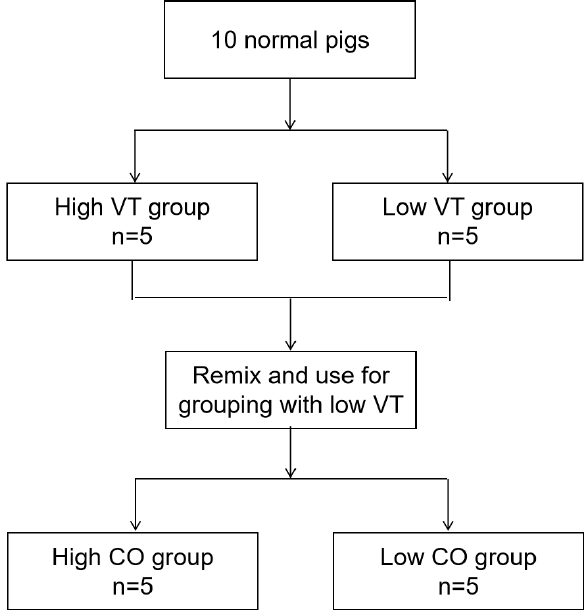
Figure 1. Flowchart of the experimental study. It should be noted that the adjustment of tidal vol- ume is rapid in the initial stage. Relevant EIT tests were carried out immediately after the adjustment of tidal volume. All parameters were obtained within 30 min. It is reasonable to believe that this had little effect on the lung structure and final pathophysiological outcome in normal pigs. Of course, to further increase the rigor of this experiment, we randomized all pigs before CO